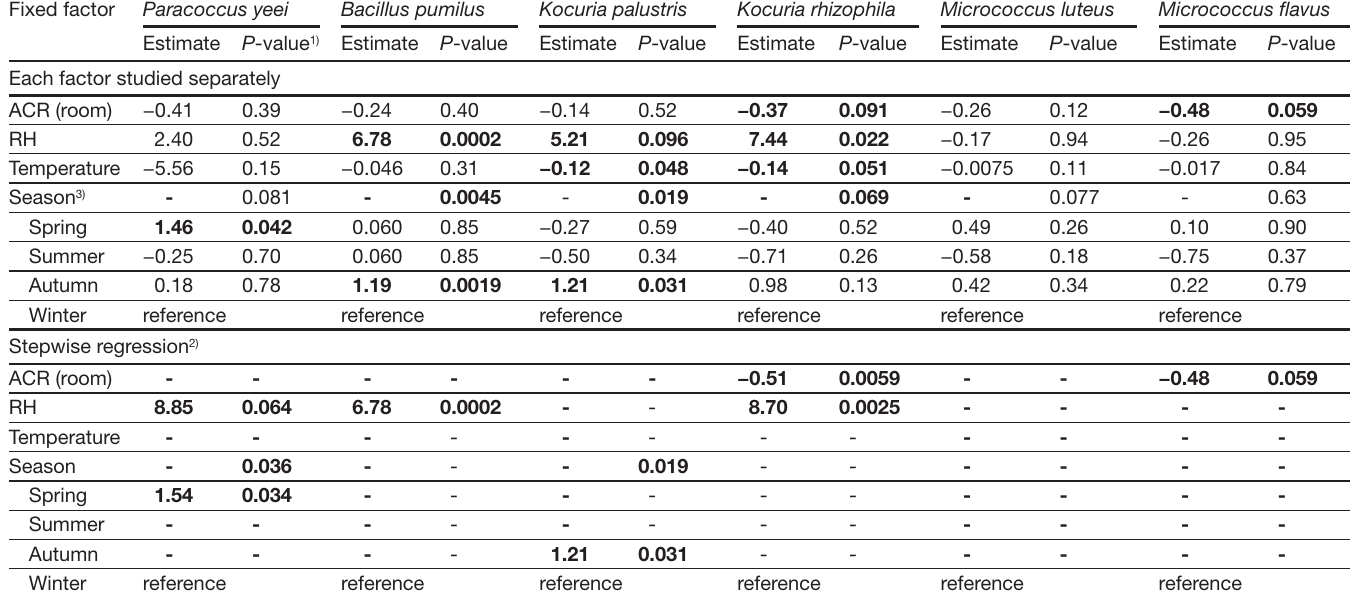
Table 2. Associations between concentrations of airborne bacteria as measured using GSP samplers repeatedly in the living room of five homes, and ACR, RH, temp and season (Study A) Fixed